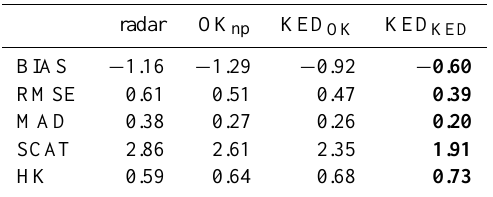
Table 3. Cross-validation skill measures for the original radar field and different merging techniques for the extended evaluation in 2008. radar OK